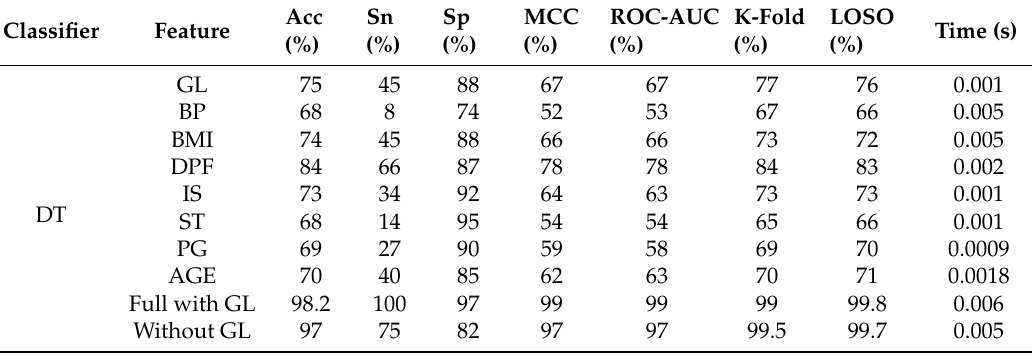
Table 5. Classification Performance on individual features, full features and features set without GL